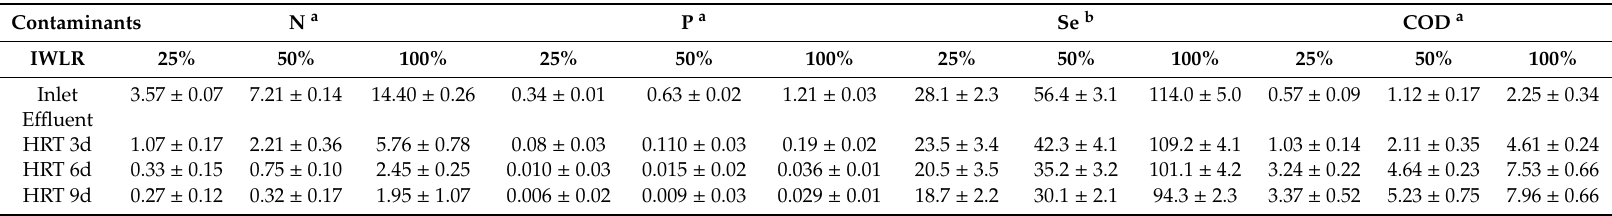
Table 3. E ffl uent quality of the second stage bioremediation test under di ff erent hydraulic retention time and initial wastewater load